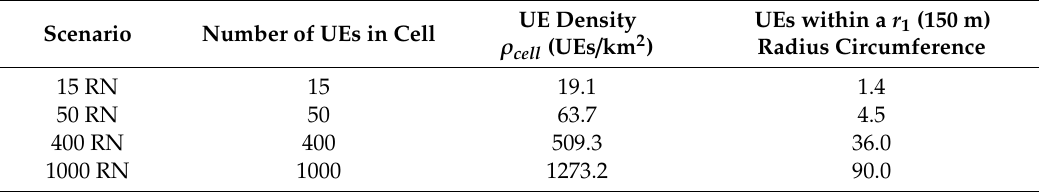
Table 1. Evaluation Scenarios and User Equipments (UE)